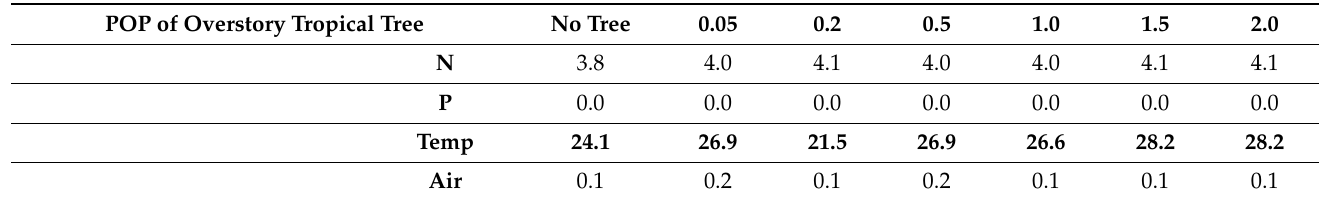
POP of Overstory Tropical